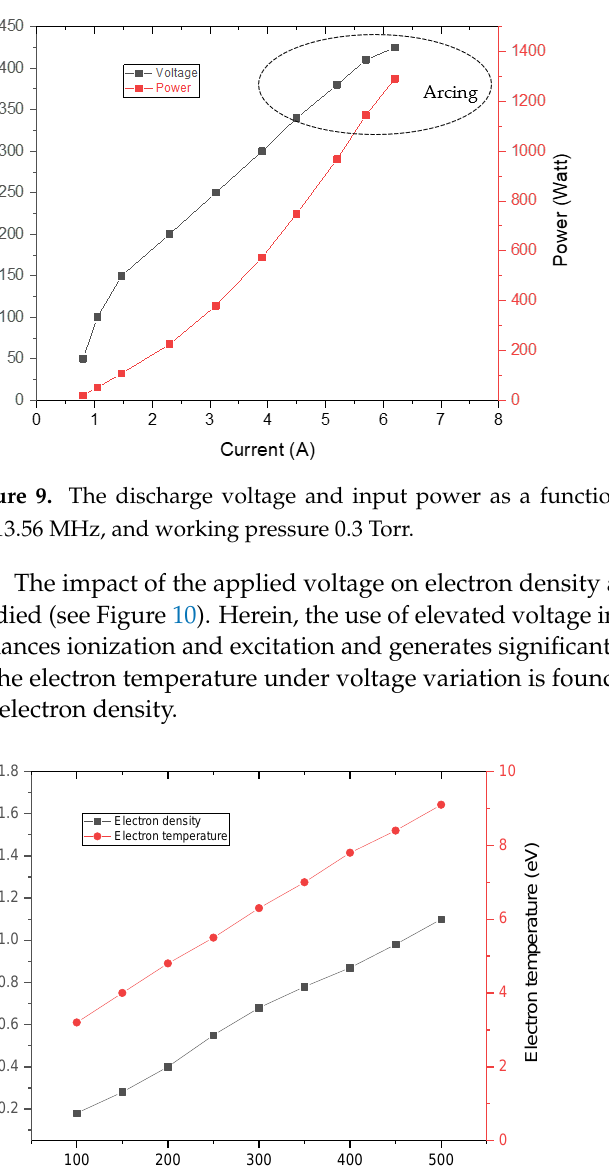
Figure 8. The current – voltage curve at various O 2 gas rates, f= 13.56 MHz, and working pressure 0.3 Torr.